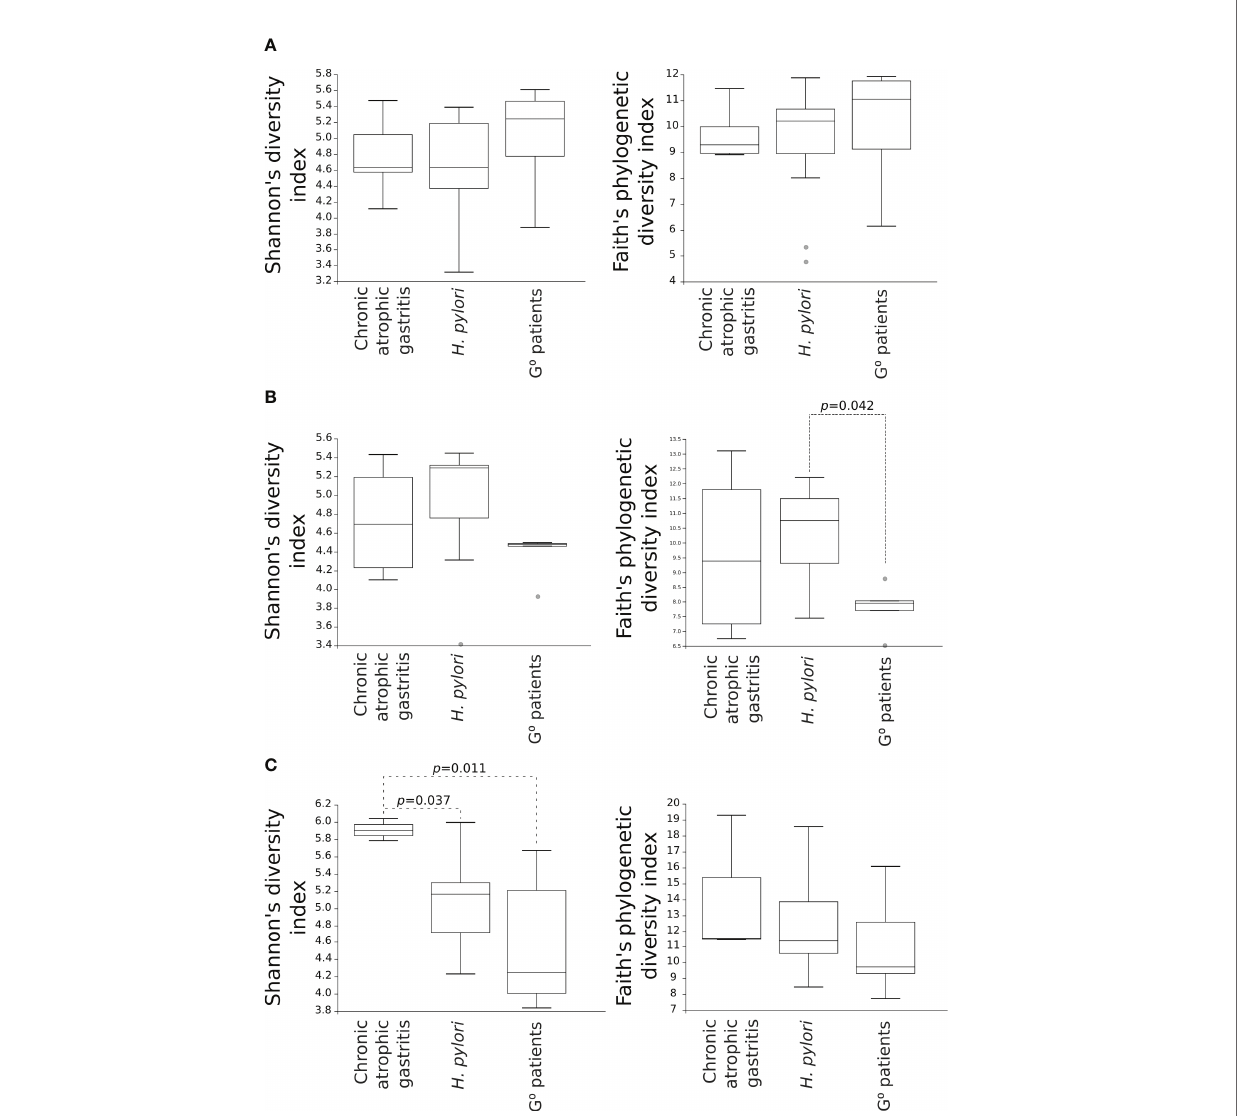
FIGURE 3 | Comparison of alpha-diversity indexes of microbial communities amongst CAG, H. pylori non-atrophic pangastritis and G 0 patients. Microbiota from gastric (A) and duodenal (B) biopsies, as well as from faecal (C) samples, are represented. Shannon ’ s diversity and Faith ’ s phylogenetic diversity indexes were used as measures of alpha-diversity within groups. Samples were rare fi ed to the smallest observed number of reads (1257 for gastric biopsies, 931 for duodenal biopsies and 2935 for faecal samples).